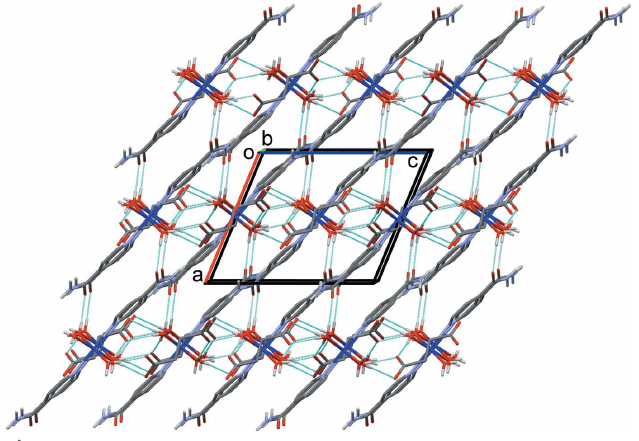
Figure 2 Aview along the b axis of the crystal packing of the title complex. Dashed lines indicate the hydrogen bonds (see Table 2).